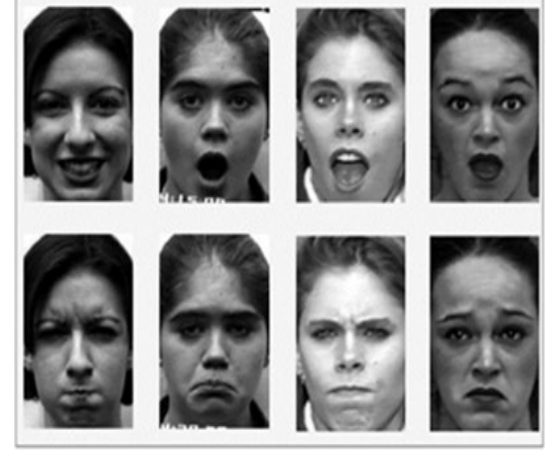
Figure 12. Samples in CK+